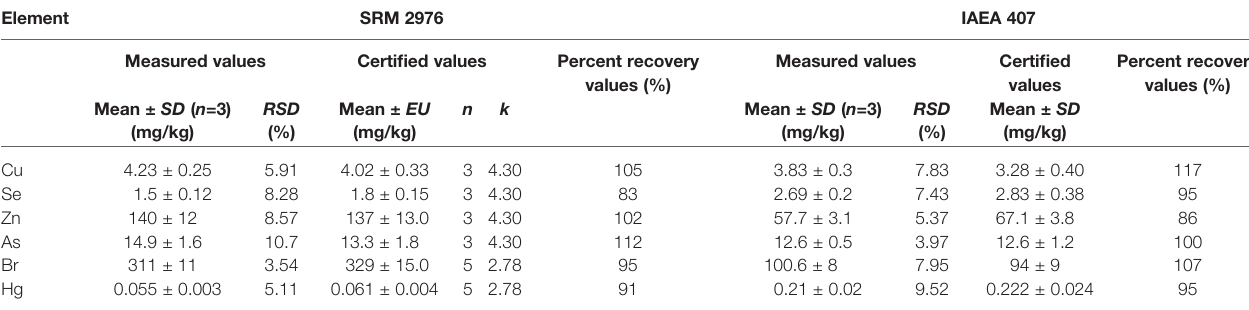
TABLE 1 | Comparison between measured and certi fi ed values of element concentration in standard reference materials. Element SRM 2976 IAEA 407 Measured values Certi fi ed